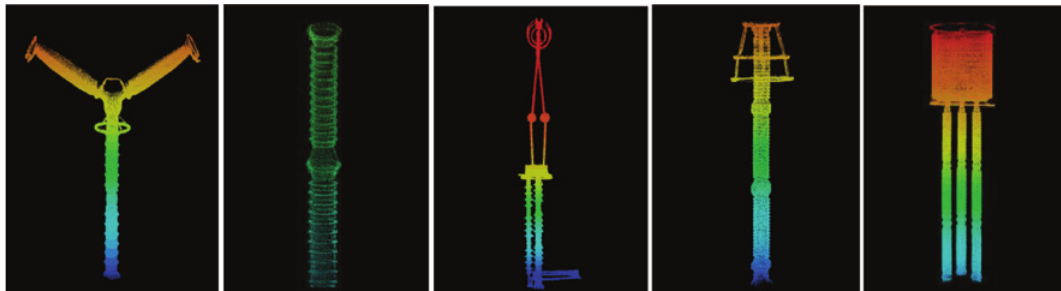
Figure 4: Five Devices Shown in Software